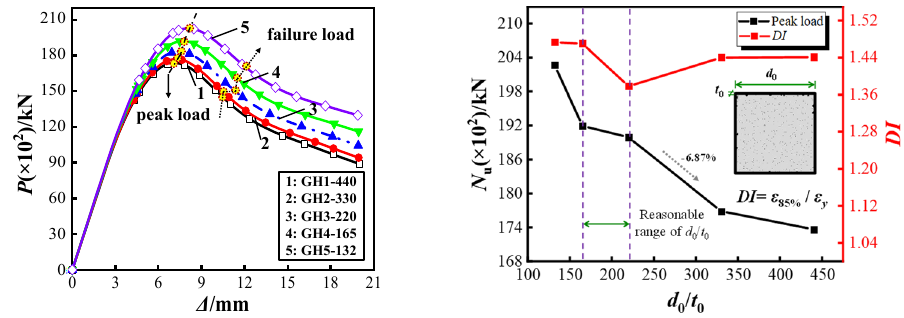
Figure 20. Load–displacement curves for different tube width to thickness ratios.